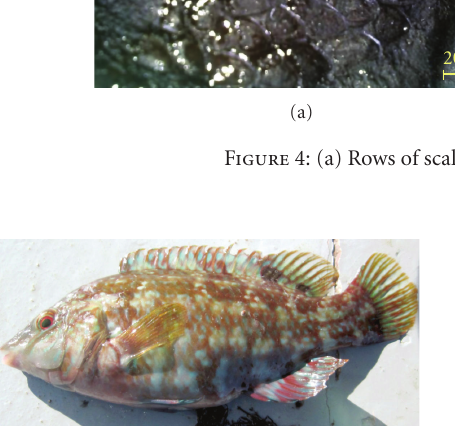
Figure 5: Symphodus bailloni , from western Black Sea coast of Turkey (on